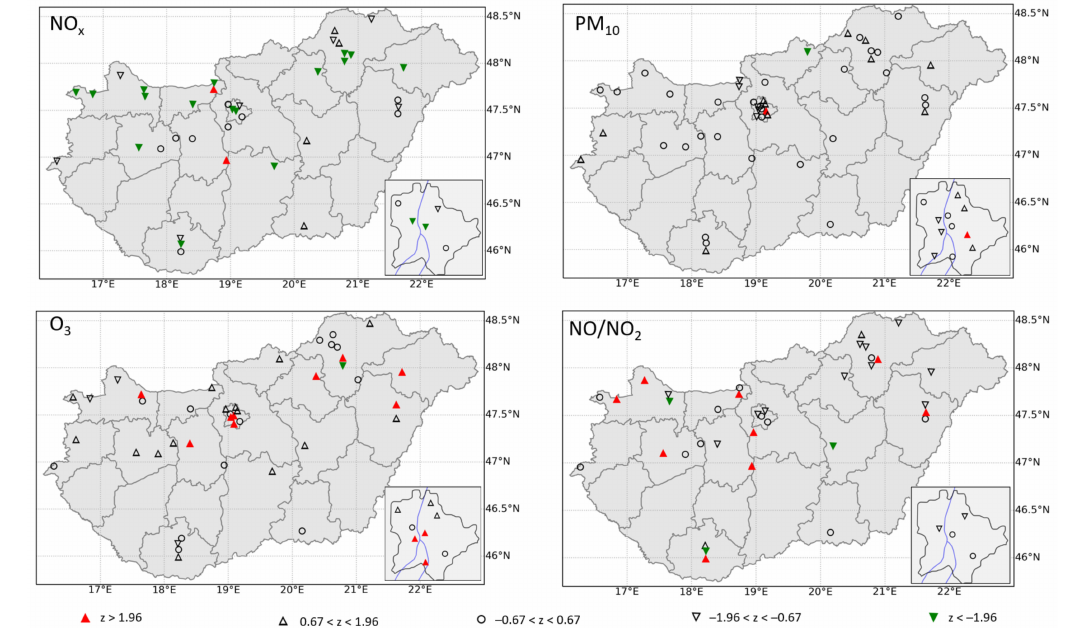
Figure 5. Difference of mean air pollutant concentrations and NO/NO 2 concentration ratio in the curfew period (28 March–4 May) in 2020 relative to the same period in 2014–2019. Green/red triangles show a significant decrease/increase (concentrations of 2020 deviating from the mean of 2014–2019 with at least 1.96 SD). Black triangles show changes between 0.67–1.96 SD. Circles show changes of any direction less than 0.67 SD. Only monitoring sites with at least 4 years with >75% daily data availability in 2014–2019 and >75% daily data availability in 2020 are marked. (Note that some markers were shifted with max. 10 km to avoid overlapping).